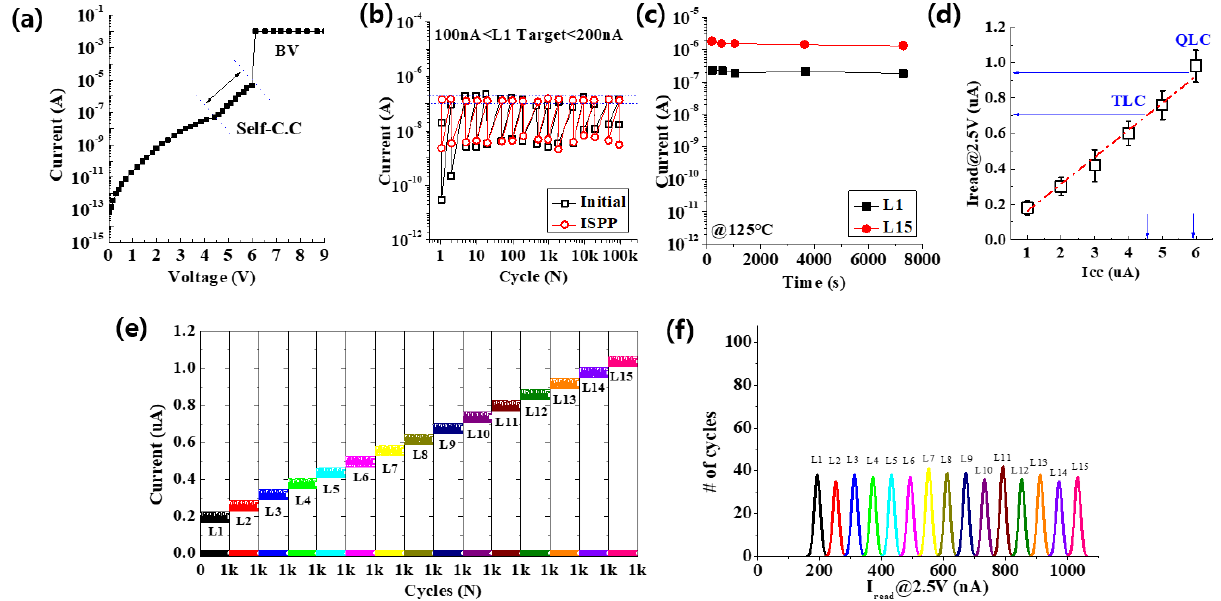
Figure 5. ( a ) Shows the self-compliance effect and the BV. ( b ) Endurance of the initial cell and the cell to which ISPP algorithm was applied. ( c ) Retention of Level 1 and Level 15 of the LRS state. ( d ) Current range per bit. ( e ) Shows the endurance of 1 k cycle for each level. ( f ) Distributions of the 4 bits/cell operation using the ISPP in array.